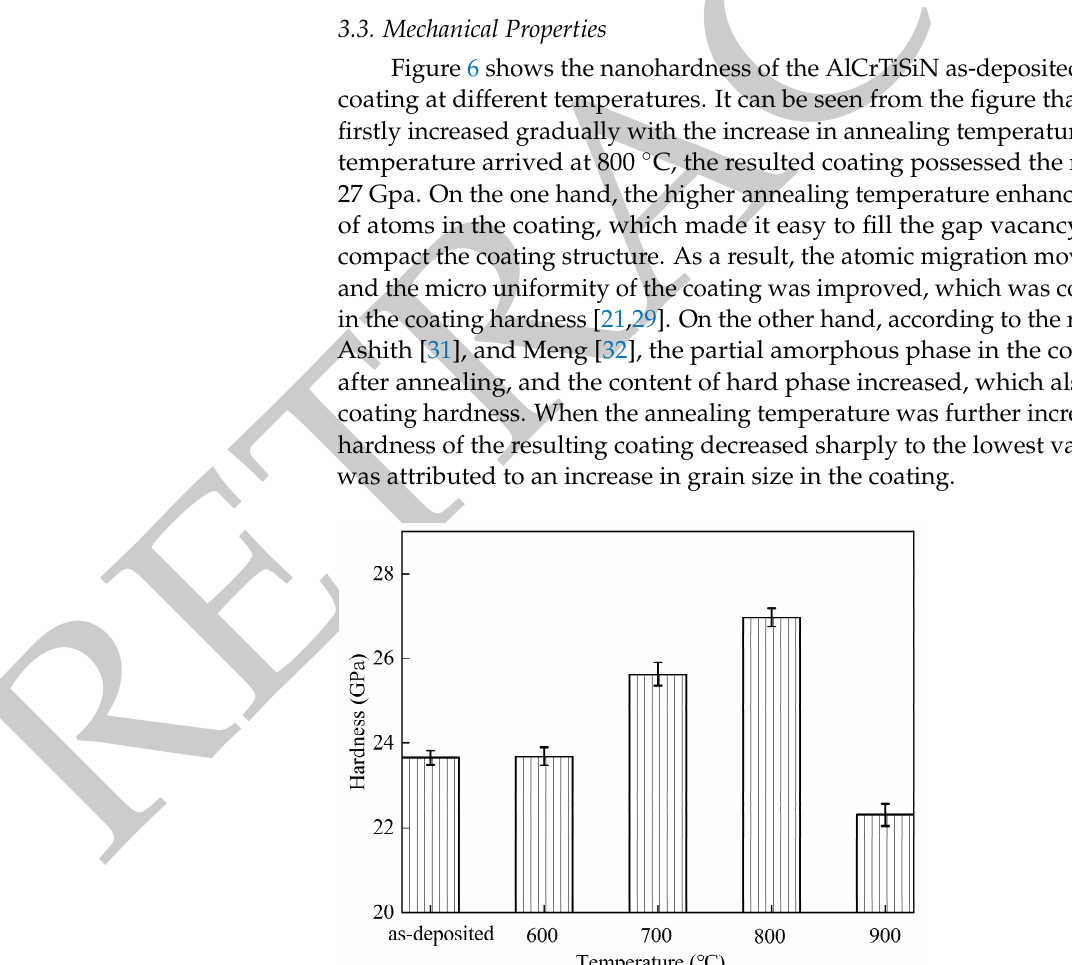
Figure 5. Cross-section morphologies of the AlCrTiSiN coatings before and after annealing, ( a ) as- deposited, ( b ) annealed at 800 °C .